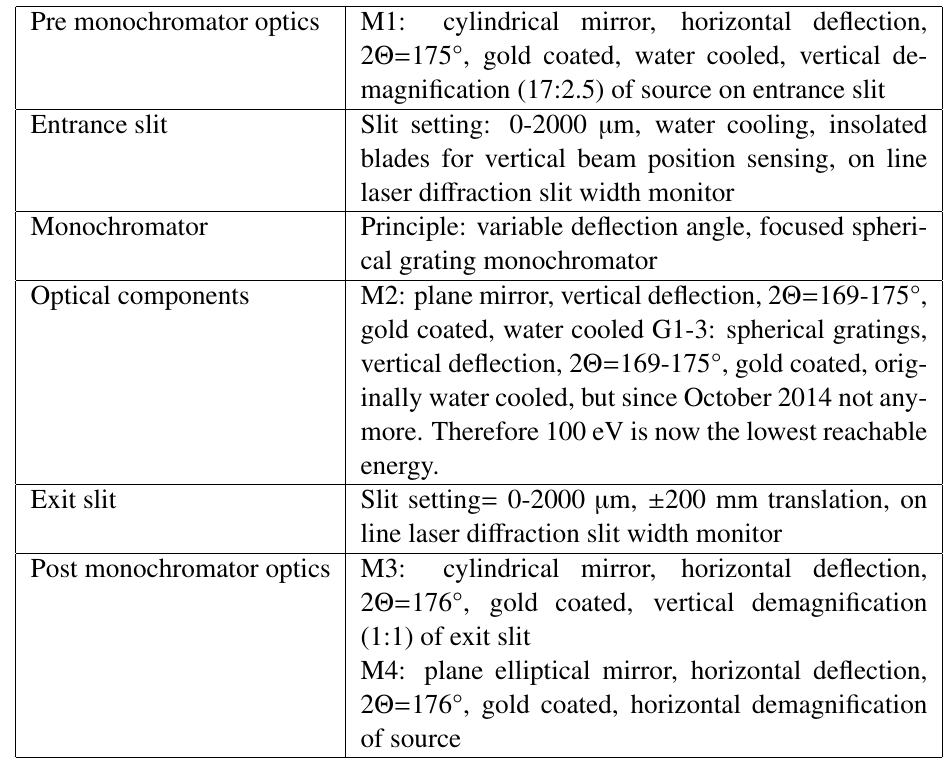
Table 2: Optical layout of beamline UE52 SGM.